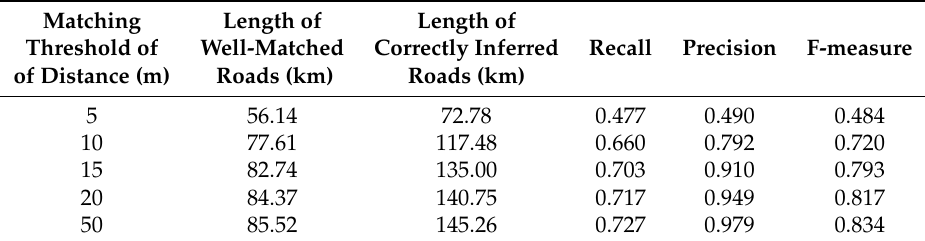
Table 3. Matching results of our method for the Wuhan dataset.